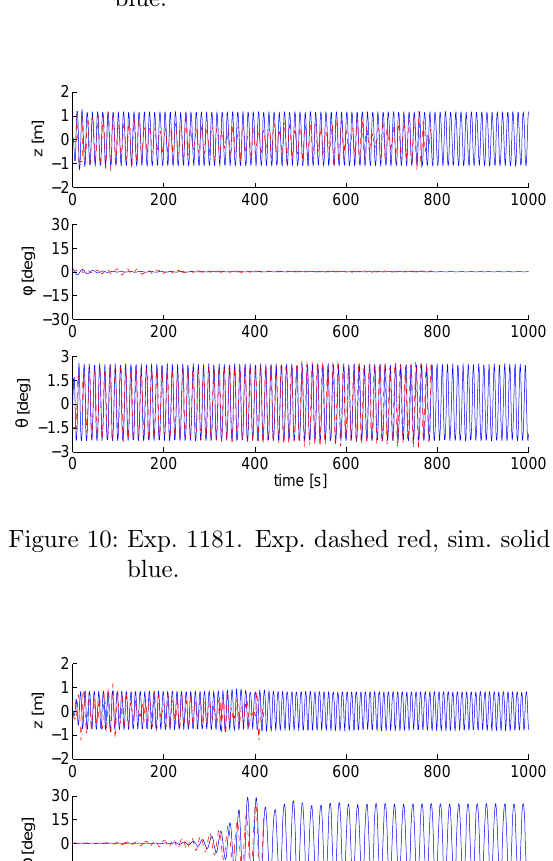
Figure 7: Exp. 1177. Exp. dashed red, sim. solid blue.